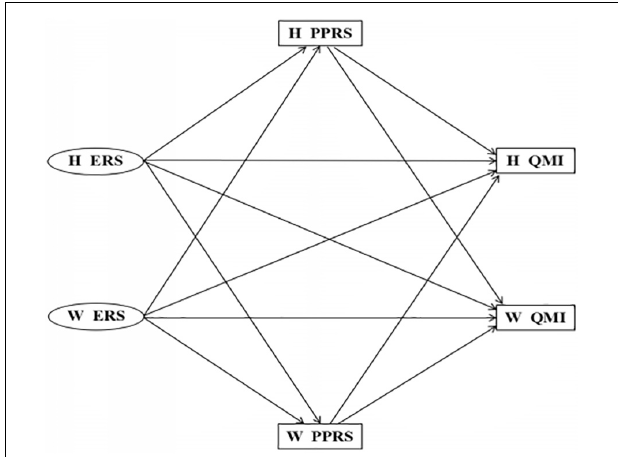
FIGURE 1 | Theoretical hypothesis model. H, husbands; W, wives; ERS, emotion reactivity scale; PPRS, perceived partner responsiveness scale; QMI, quality of marriage